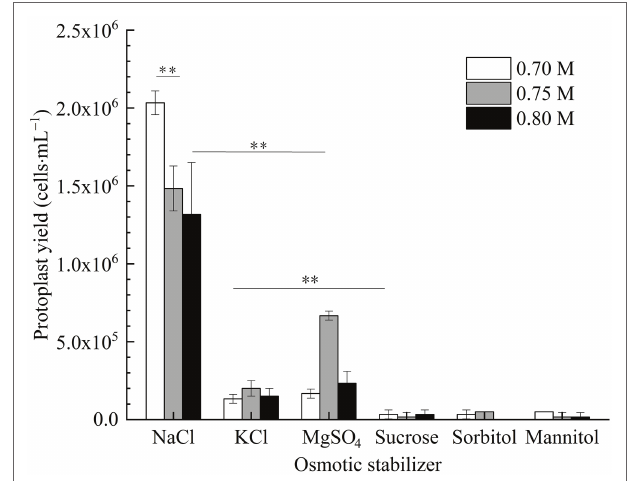
FIGURE 3 | Production of strain D-1protoplasts in different osmotic stabilizers ( ** p < 0.01).